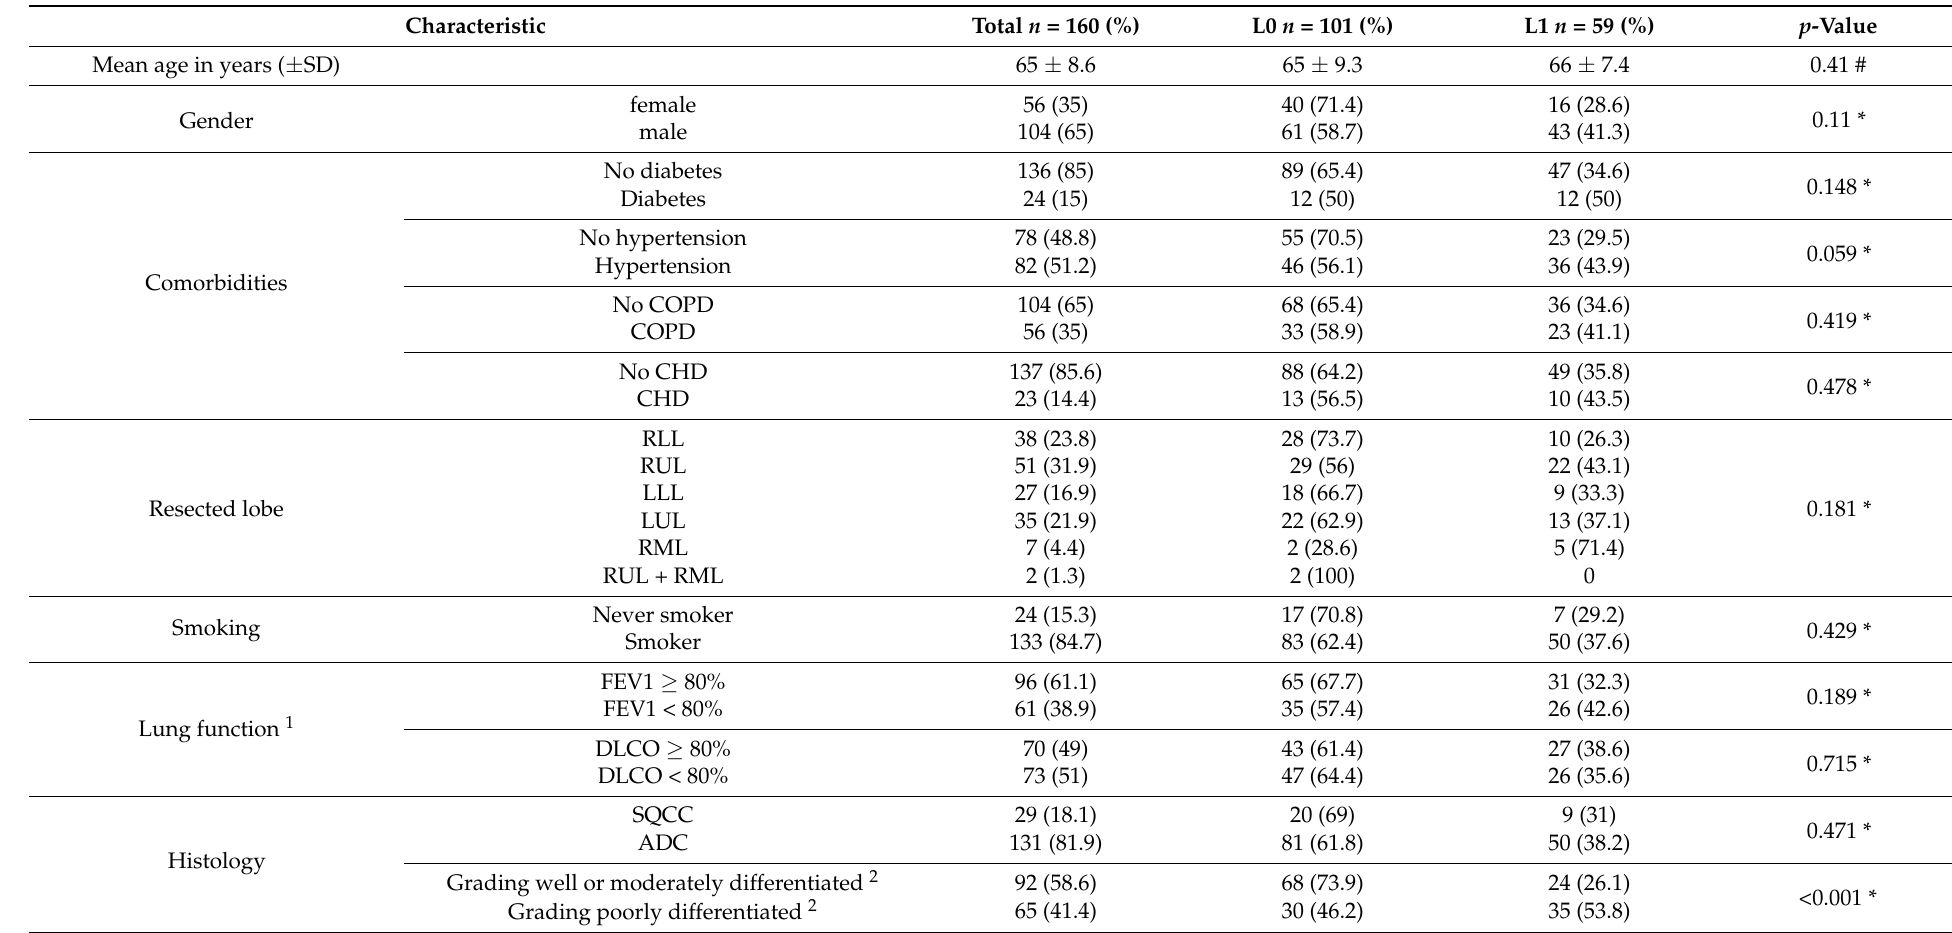
Table 1. Association of lymph vessel invasion with the patients’ clinicopathological parameters ( n = 160). Characteristic Total n = 160 (%) L0 n = 101 (%) L1 n = 59 (%) p